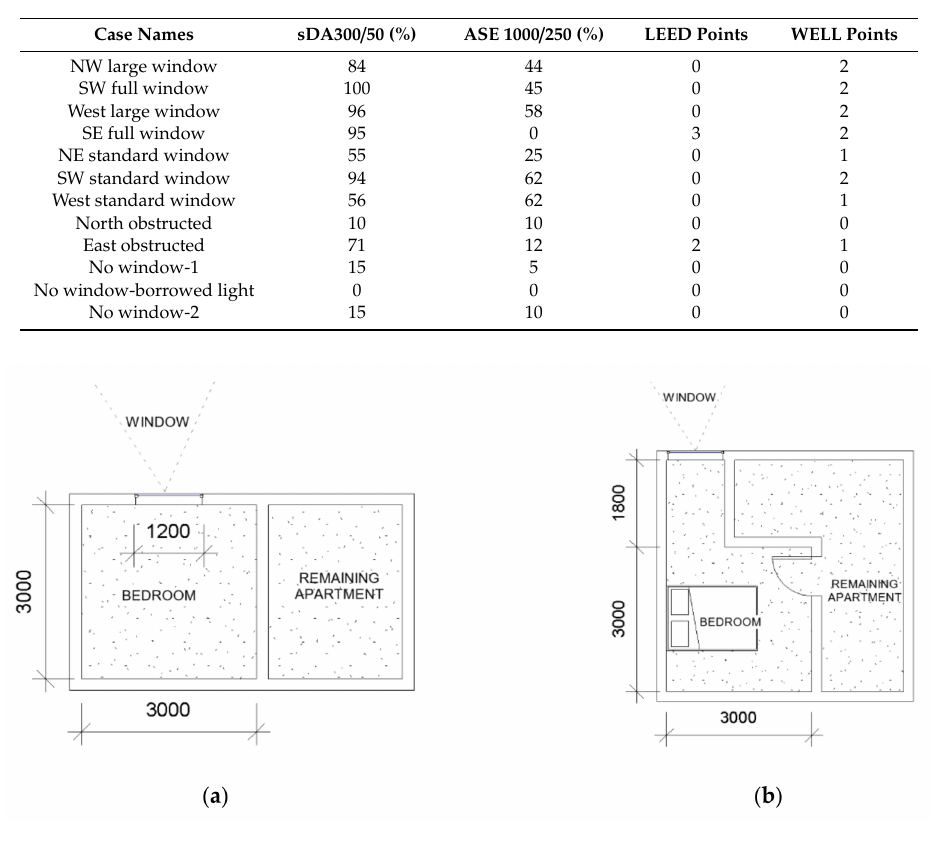
Table 3. Annual daylight percentage.